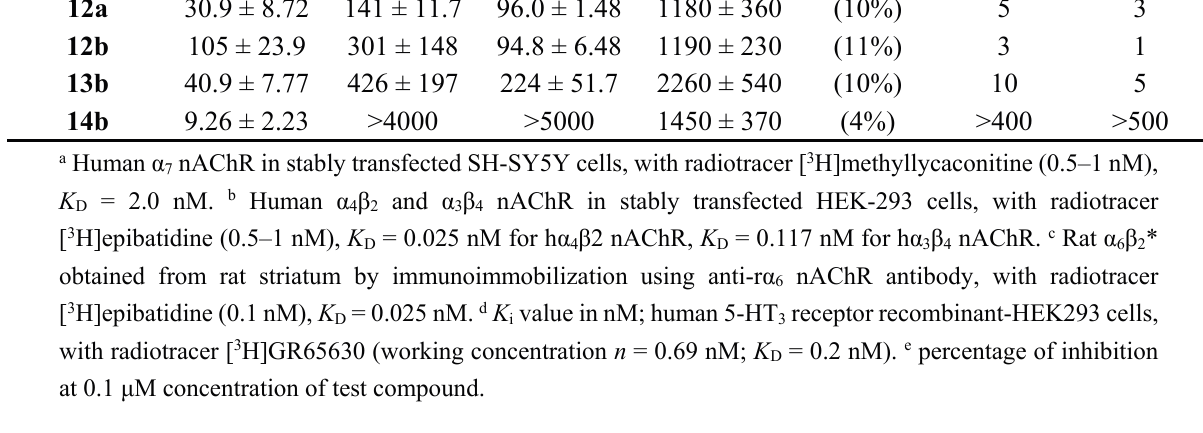
>500 3 H]methyllycaconitine (0.5–1 nM),